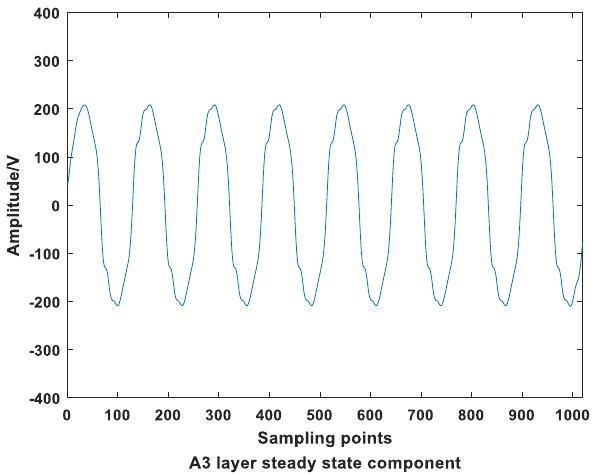
Figure-6. Reconstructed waveform of A3 layer.